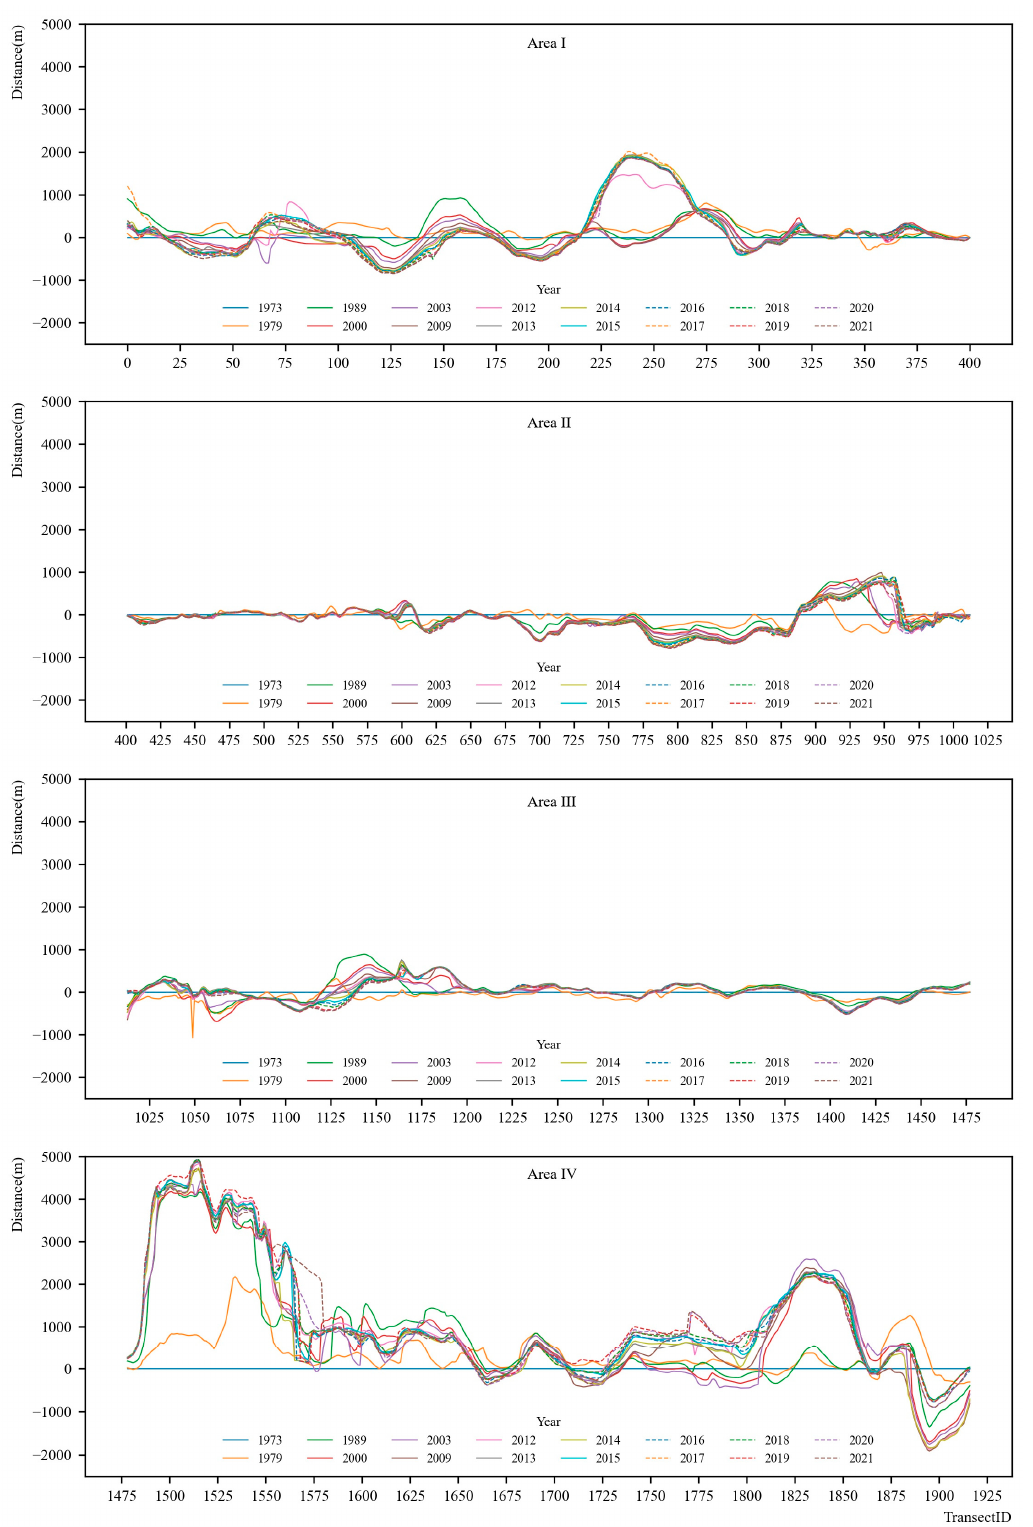
Figure 6. Spatial and temporal change in the coastline. The horizontal axis shows the number of coastline transects, and the vertical axis is the distance between the baseline and coastline for different periods of the transect. The 0 indicates baseline; lines below the baseline indicate that the coastline is receding toward the continent; lines above the baseline indicate expansion of the coastline toward the